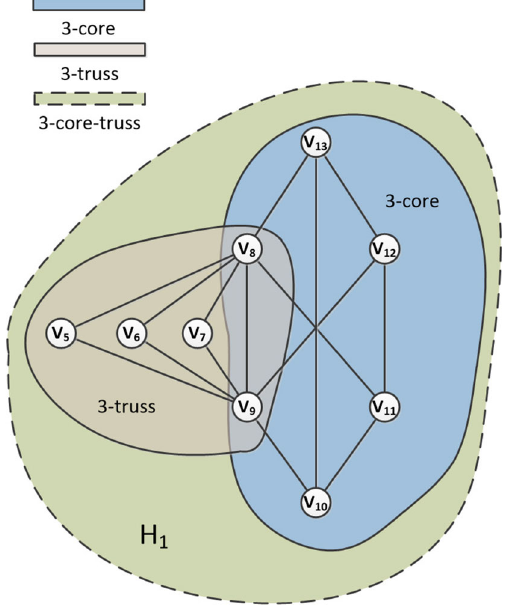
Fig. 1 An example of graph H 1 with k - core - truss , k -core, and k - truss, where k ¼ 3 and parameter a ¼